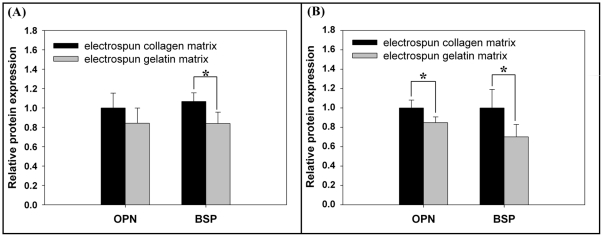
Effects of matrix on BSP and OPN protein expression in MG63 osteoblasts-like cell.Western blot analysis for BSP and OPN proteins in cells cultured for (A) 14 and (B) 21 days. Densitometric quantitation of the OPN and BSP protein band were performed after normalizing to nucleophosmin B23 levels (Figure S2 shown the images of full western blots). Data are shown as the fold change of the corresponding on the electrospun collagen matrix. The expression level of BSP and OPN proteins showed a significant increase in cells grown on EC at 21 days. Data represent mean ± SD, n = 3. Statistical analysis was compared between EC and EG. (*) denotes a significant difference (p<0.05).